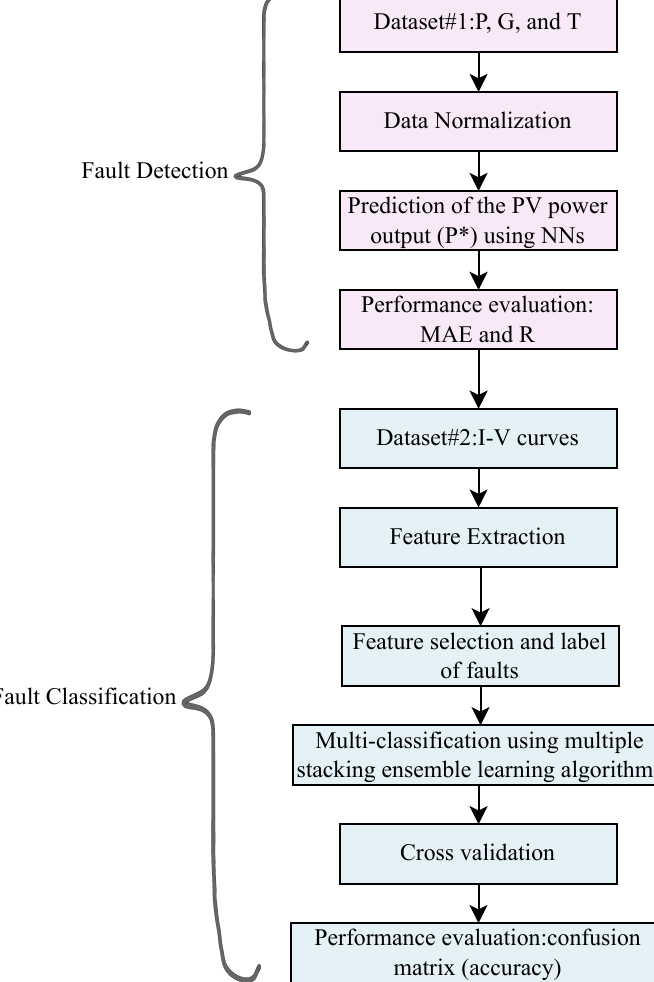
Figure 6. The fault detection and classification